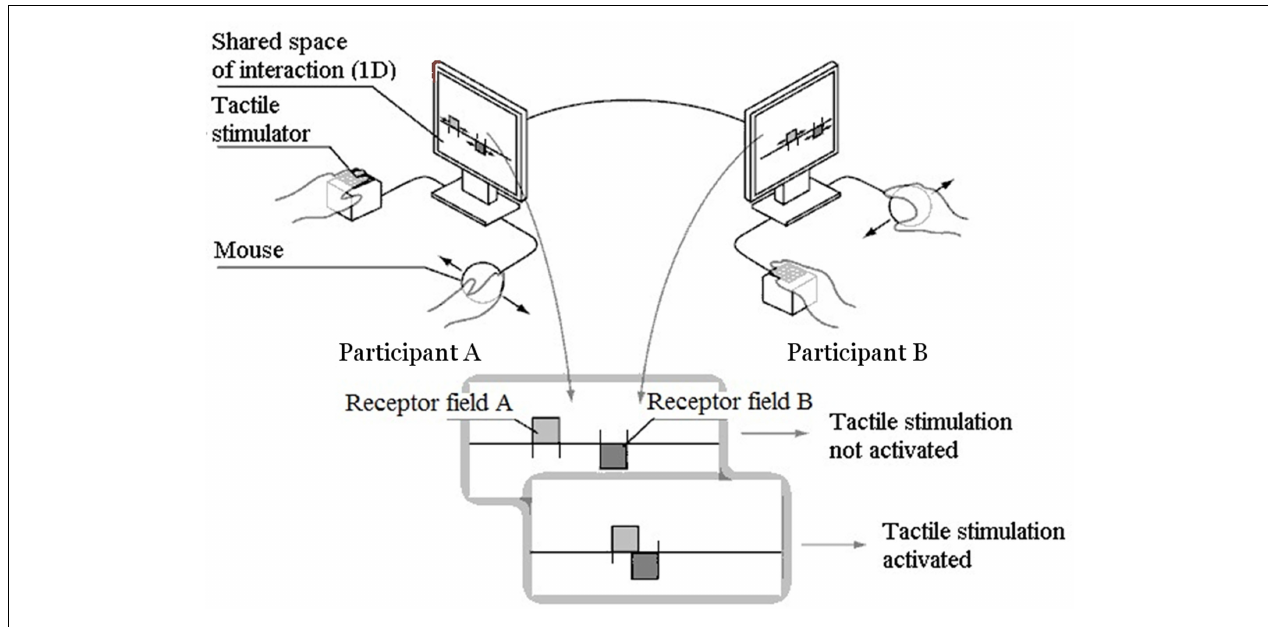
each other, each user receives a tactile stimulus on his free hand. Here, the receptor fields can be perceived (they are thus also body-objects perceivable by the